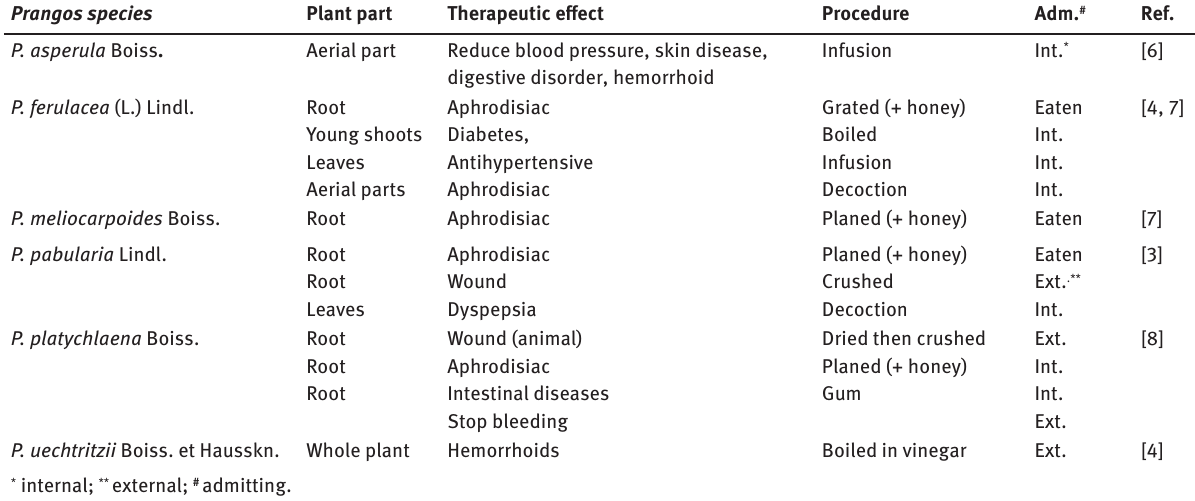
Table 1 : Ethnopharmacological data on the Prangos species (literature